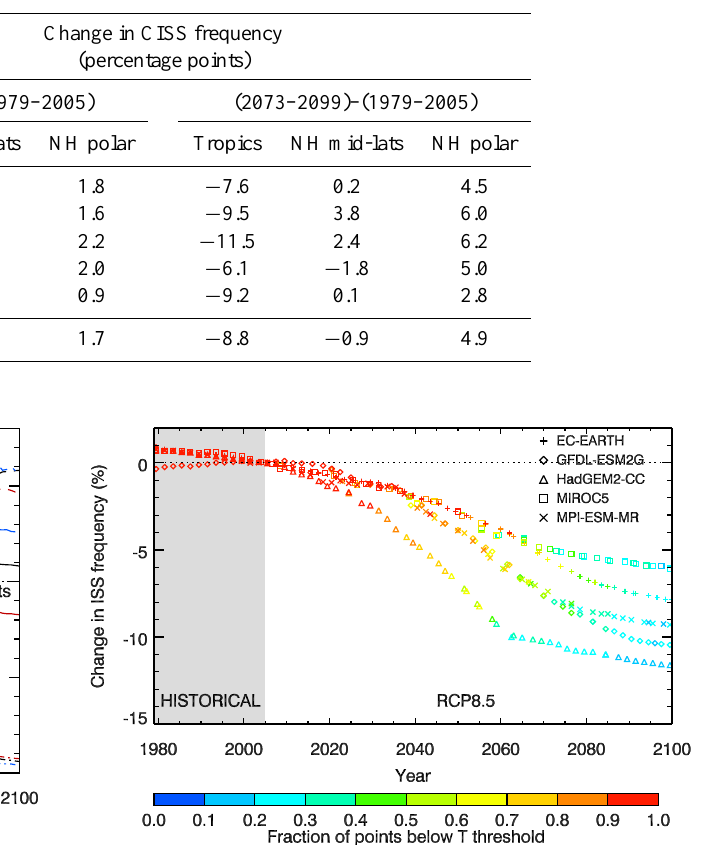
Figure 5. Time series of the multi-model-mean change in CISS frequency (in percentage points) at 250hPa from 1979 to 2099, calculated for each year as the mean CISS frequency minus the 1979–2005 average (the historical period, shown by grey shading). The change is calculated separately for the tropics (dashed-dotted lines), NH mid-latitudes (solid lines) and NH polar (dashed lines) regions, for the annual (black lines), DJF (blue lines) and JJA (red lines) mean changes. The changes are calculated separately for each CMIP5 model and averaged to provide a multi-model mean; a 10- year running mean has been applied to each time series before plot- ting.